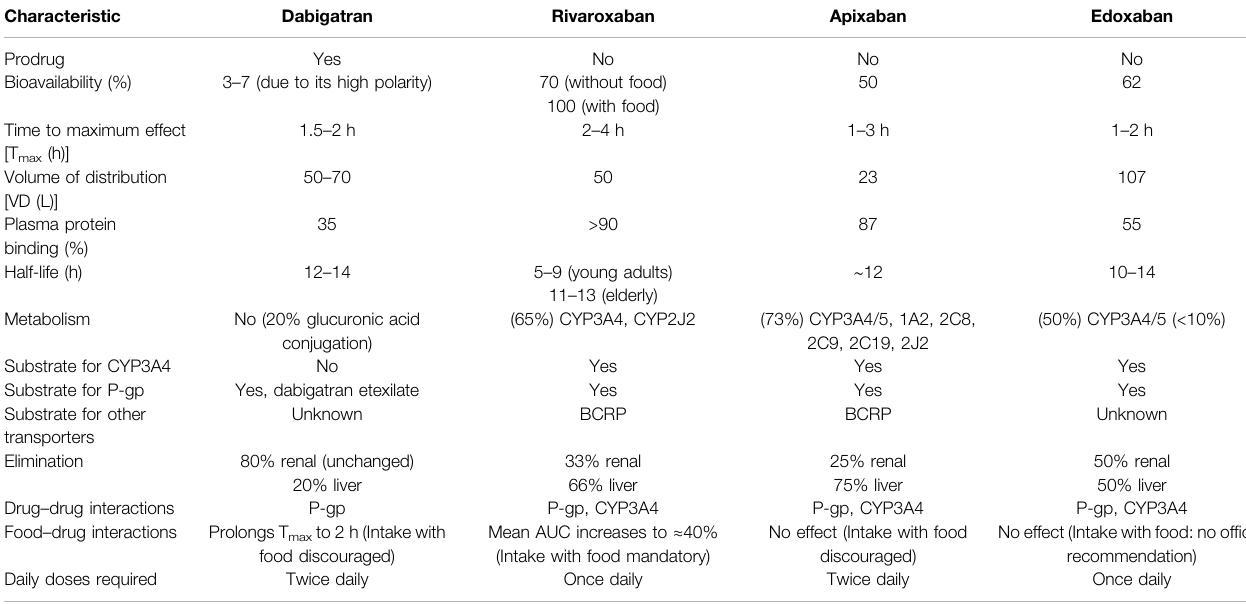
TABLE 1 | Summary of main pharmacokinetic characteristics of DOACs.